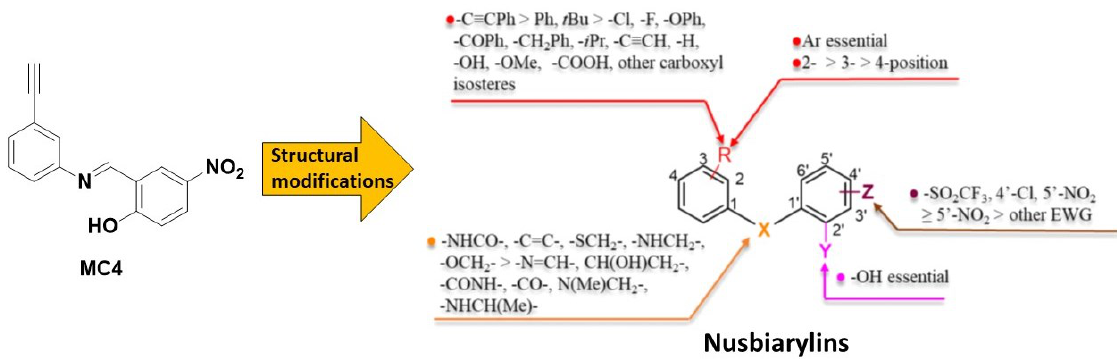
Figure 1. Structures of MC4 and its derivatives (nusbiarylins), and their structure–activity relation- ship (SAR) against S. aureus .